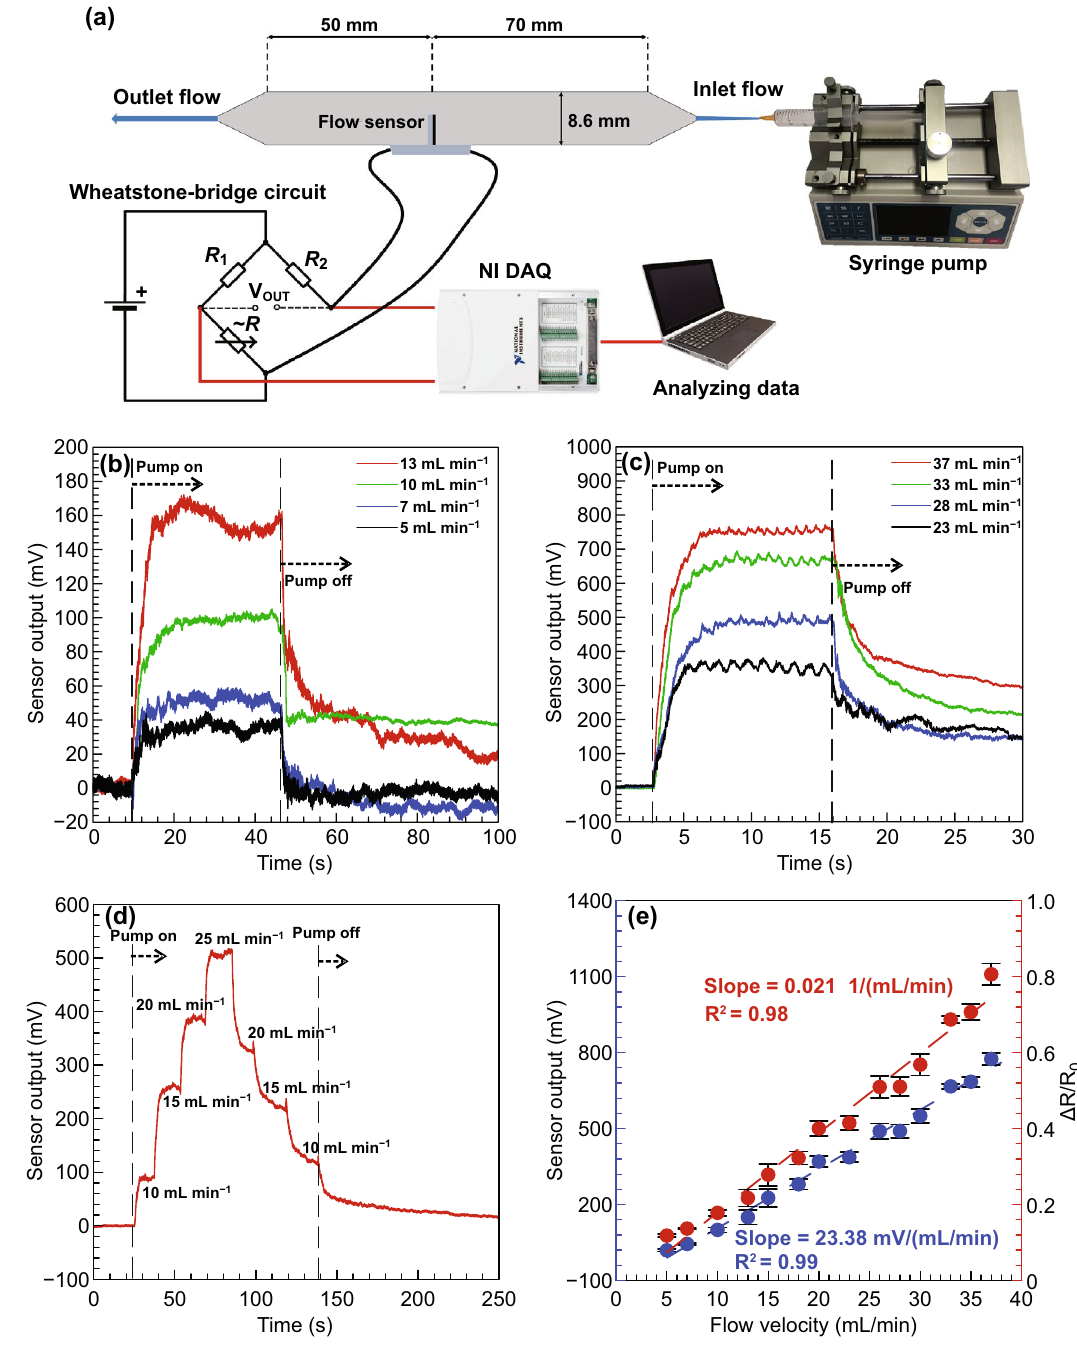
Fig. 4 a Schematic diagram of the experimental setup for steady-state flow testing inside a straight channel. b Sensor output for low flow veloci- ties and c high flow velocities. d Sensor output as a function of time for various flow velocities. e Sensor output as a function of flow velocity (calibration